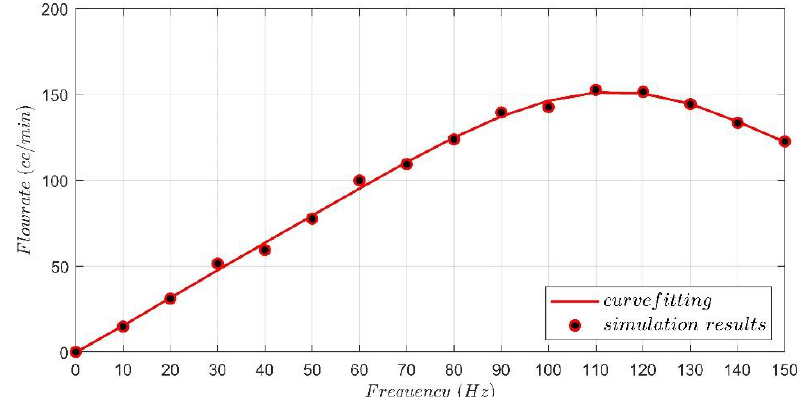
Figure 10. The flow rate simulation result at several driving frequencies.